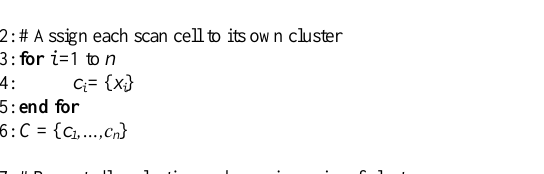
Algorithm 2 Scan correlation clustering